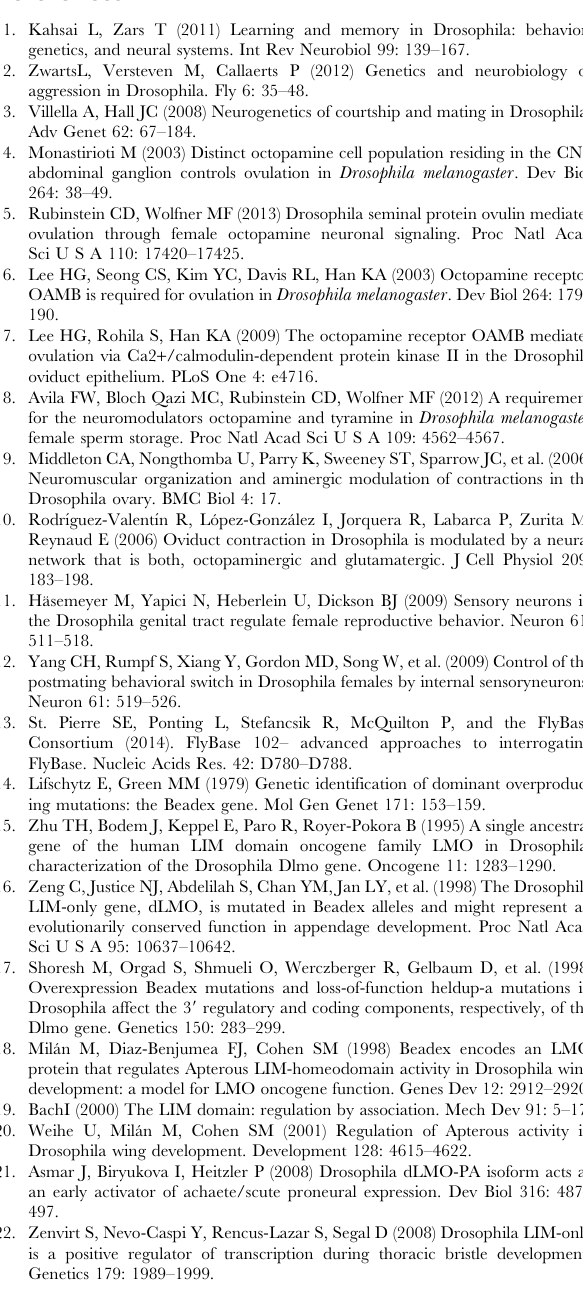
Figure S7 Crop distension in Bx 7 mutant females reduces abdominal cavity space. Bx 7 mutant females showed increase in the abdominal size due to distension of crop caused due to reduced food movement along the gastric tract. This might lead to inhibition of mature egg accumulation in the Bx mutant ovaries. Red arrow indicates bulged abdomen and crop. (TIF) Figure S8 Bx does not regulate female reproduction through the sensory neurons in the female reproductive tract. Bx was knocked down in the sensory neurons in the female reproductive tract with ppk -Gal4. However, this does not reduce either fecundity (A) or fertility (B) of the females.